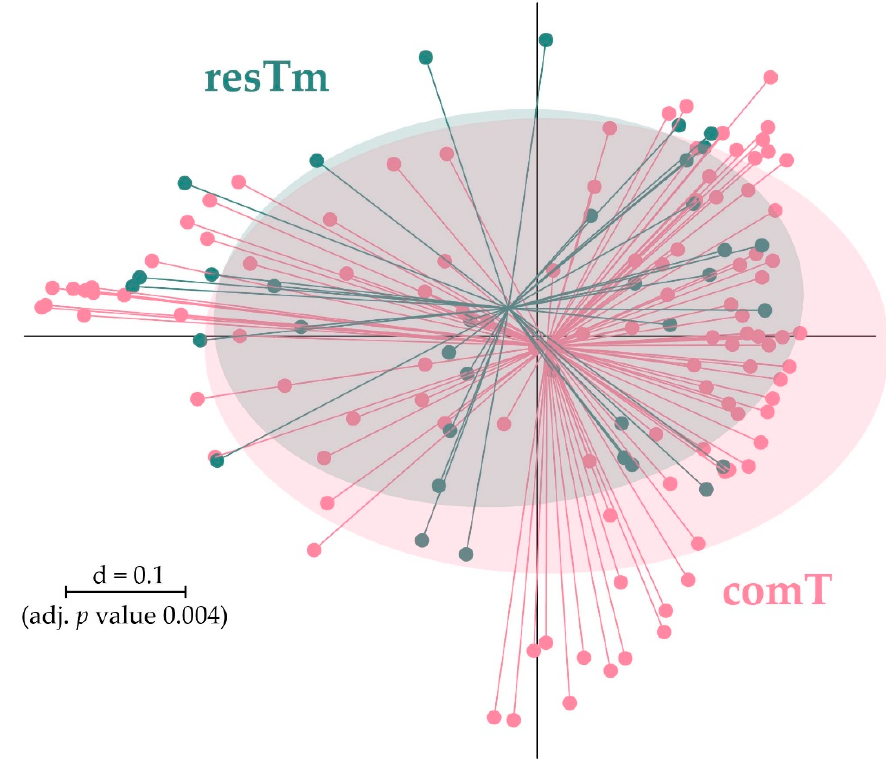
Figure 4 . Pairwise β -diversity comparison of resTm and comT displayed as multidimensional-scal- ing (MDS) plot. The scale is an indicator for the differences in the phylogenetic makeup of microbiota between samples ( β -diversity) based on general UniFrac distances (d = 0.1, 10% difference). resTm, residual tick material; comT, complete Ixodes ricinus tick.